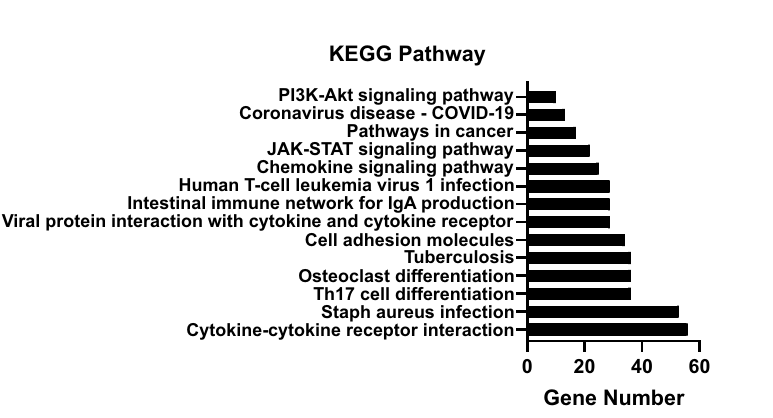
Figure 3. Bar graph of the top fourteen Kyoto Encyclopedia of Genes and Genomes (KEGG) pathways differentiating cluster 1 from cluster 2 by gene over-representation analysis (gene number) based on the differentially expressed genes following poly(I:C)